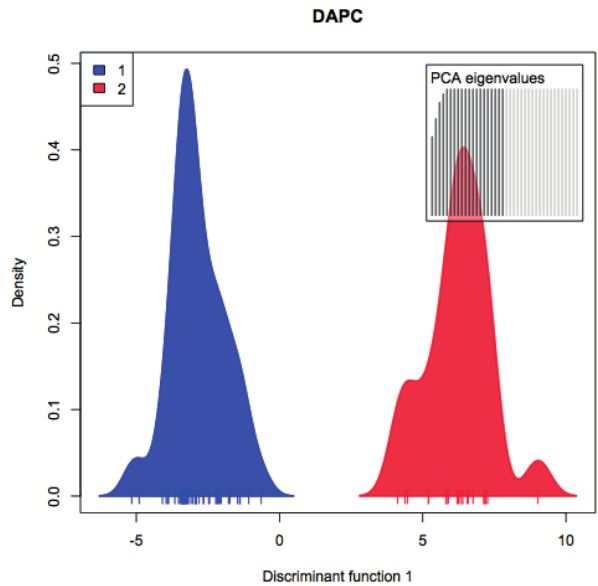
Figure 7. DAPC plot showing differentiation of female (1) versus male (2). date palm trees based on associated marker loci.